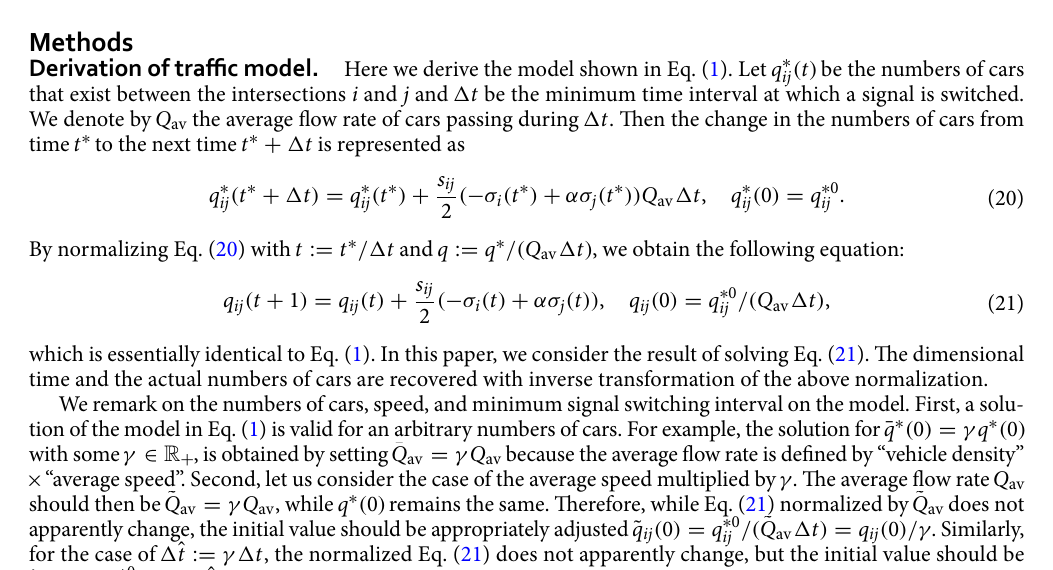
Figure 9. Correspondence between η and θ . ( a ) Time average of the objective function ¯ H versus θ , when the value of η is fixed as η = 1.0 . The cases with α ∈ { 0.0, 0.5, 0.995 } are shown. ( b ) ˆ θ versus η for α ∈ { 0.0, 0.5, 0.995 }